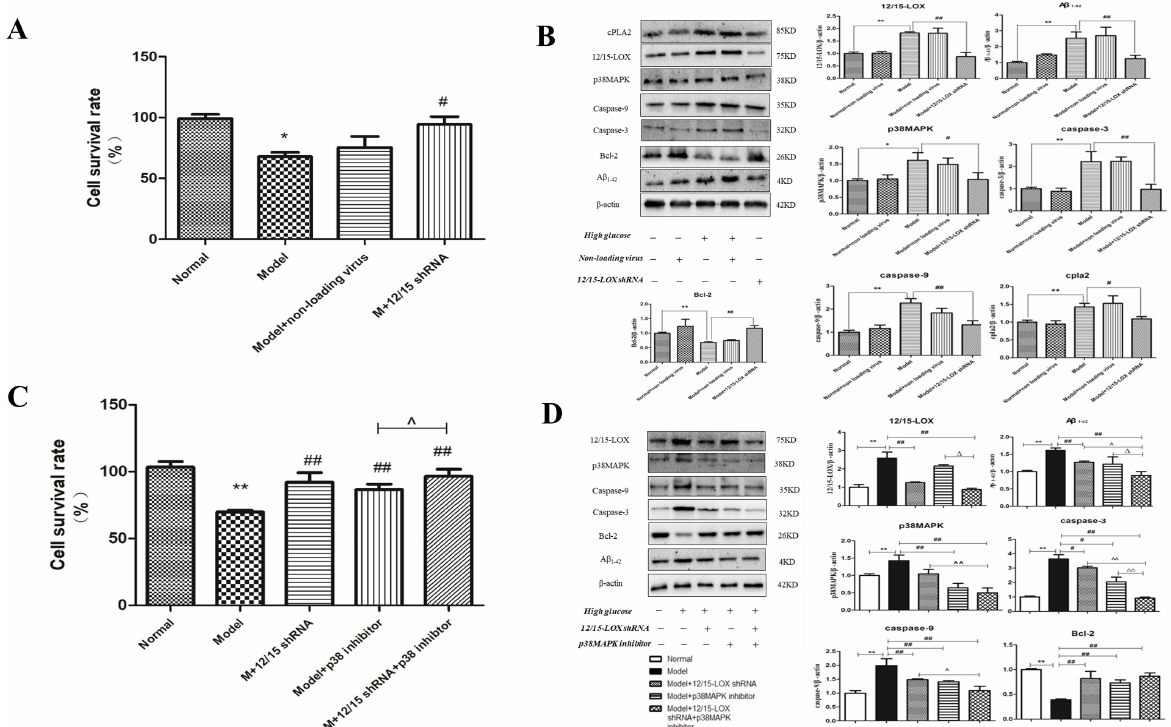
Figure 5. The effect and mechanism of lentiviral knockdown 12/15-LOX in HT22 cells damaged by high glucose. The effect of knockdown 12/15-LOX in HT22 cells damaged by high glucose ( A ). Changes in proteins in knockdown 12/15-LOX HT22 cells damaged by high glucose ( B ). The effect of knockdown 12/15-LOX with p38MAPK inhibitor in HT22 cells damaged by high glucose ( C ). Changes in proteins in knockdown 12/15-LOX with p38MAPK inhibitor in HT22 cells damaged by high glucose ( D ). * p < 0.05, ** p < 0.01 compared with normal group; # p < 0.05, ## p < 0.01 compared with model group. ^ p < 0.05 and ^^ p < 0.05. ∆ p < 0.05 and ∆∆ p < 0.05.